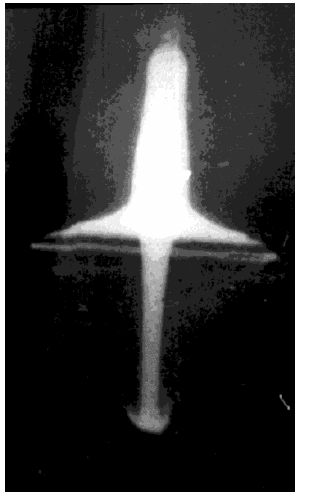
Figure 7 – Cumulative beam formation